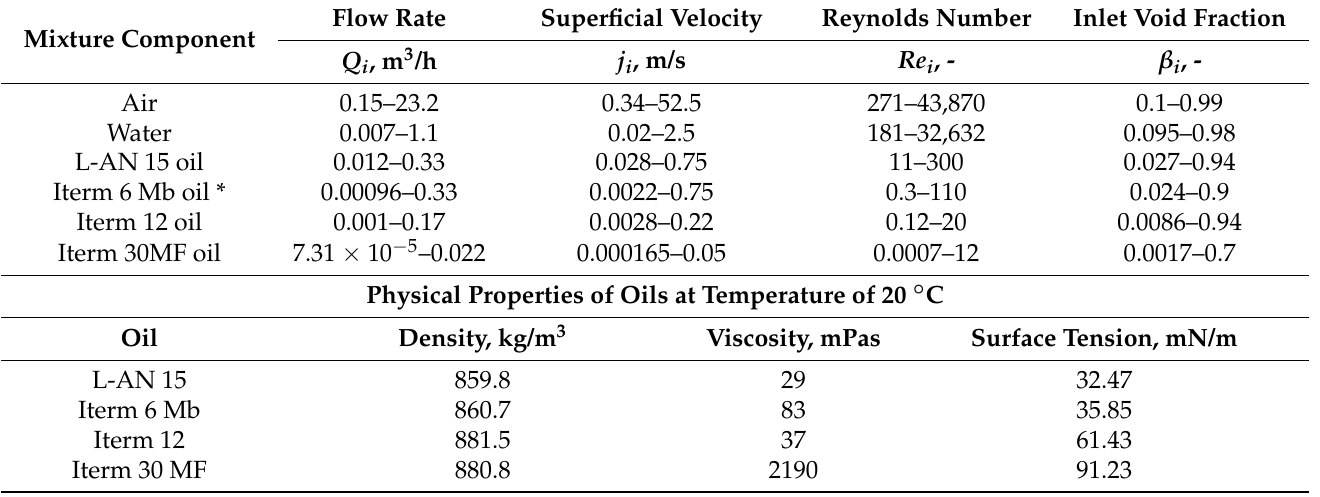
Table 2. The range of parameters change in multiphase mixture